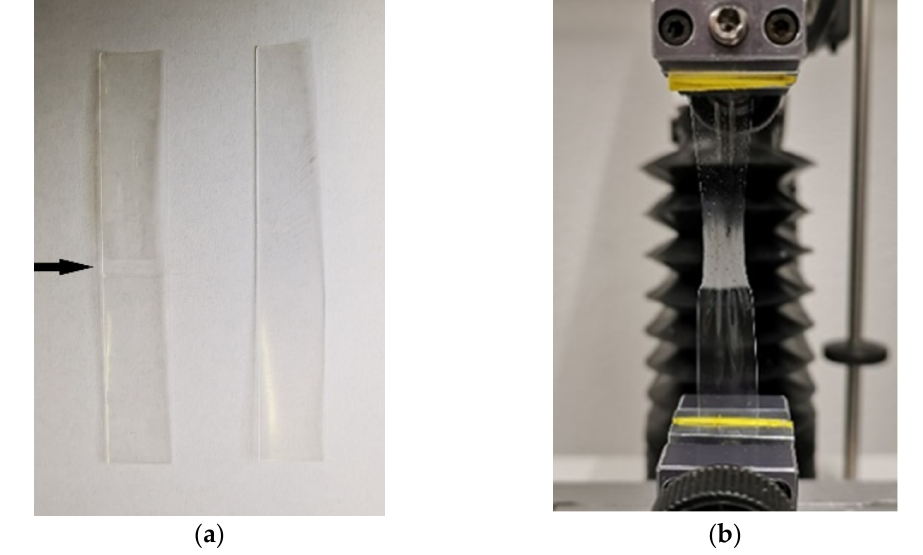
Figure 6. ( a ) Cut-to-size strips for tensile testing (left: HPMC + HPC, arrow marks the polymer junction, right: HPC) and ( b ) tandem film during the measurement.